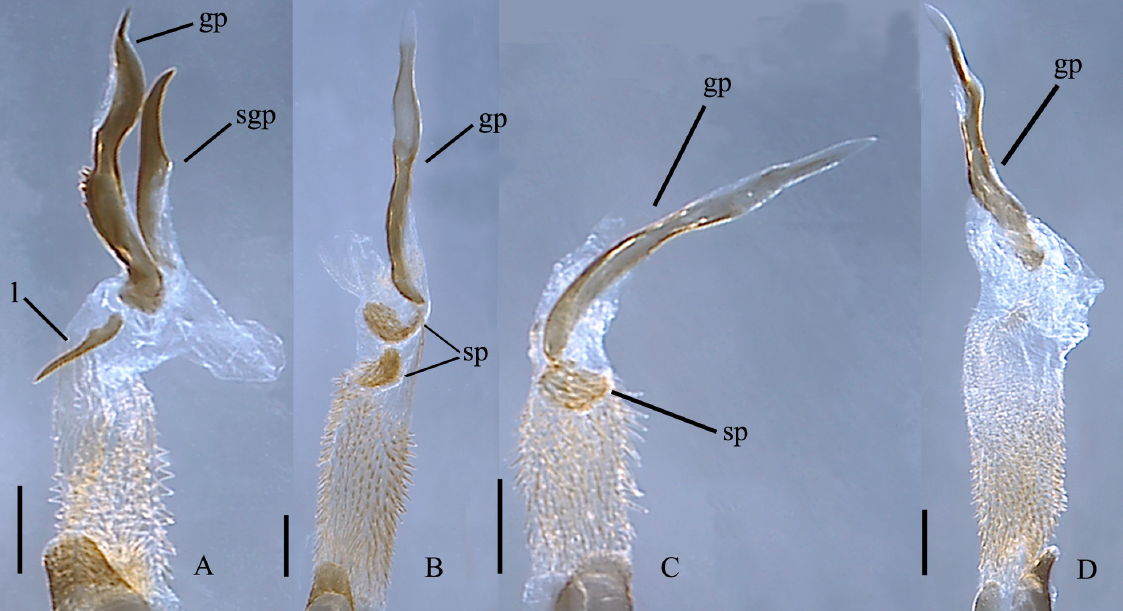
Fig. 8. Endophallus of Intybia spp., A . Intybia histrio (Kiesenwetter, 1874). B . I. pelegrini pelegrini (Pic, 1910). C . I. takaraensis (Nakane, 1955). D . I. kishiii (Nakane, 1955). Abbreviations: gp = gonoporal piece; l = ligula; sgp = semi-gonoporal piece; sp = spinous plate. Scales = 0.1